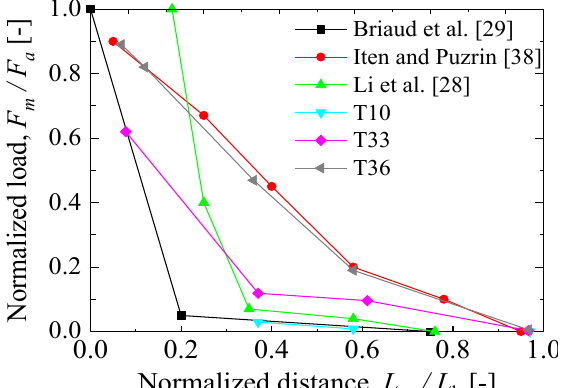
Figure 15 - Load distributions in the bonded length of the instrumented anchors compared with results reported in the